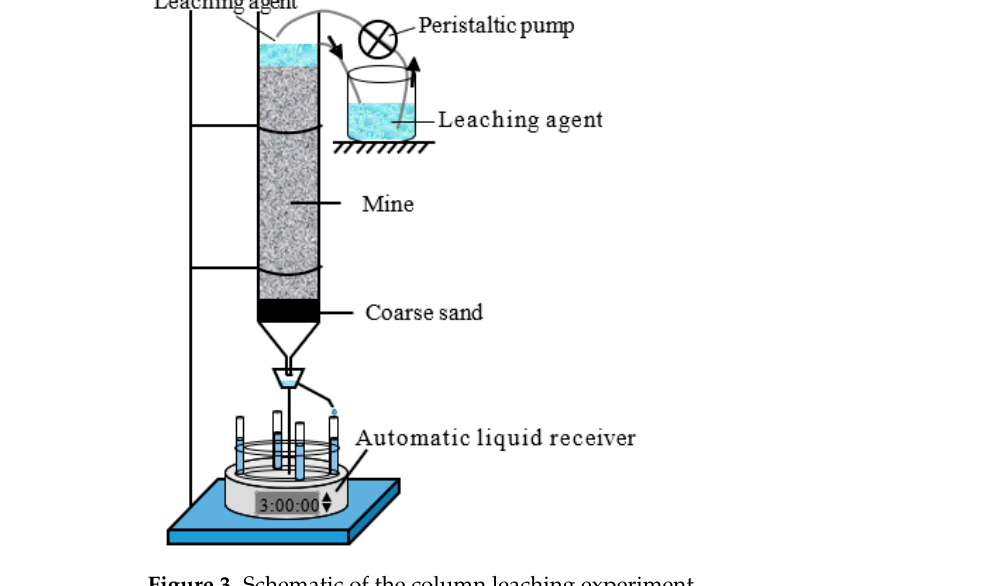
Figure 3. Schematic of the column leaching experiment.